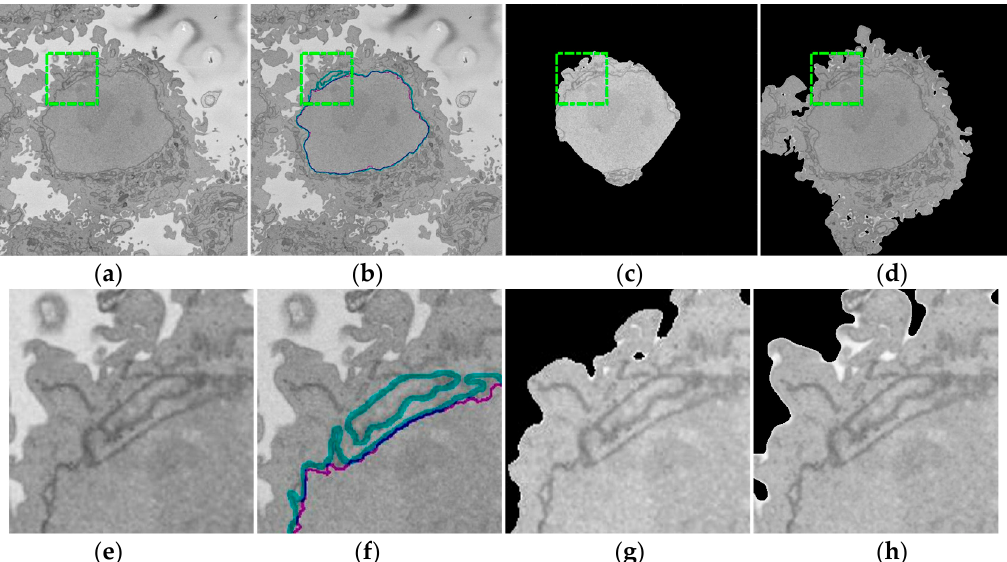
Figure 6. Comparison of the algorithm against ground truth (GT) and Active Contours. ( a ) One representative slice from one HeLa cell (red box in Figure 1b). Green dashed-dotted box denotes the region of interest (ROI) that is magnified in ( e–h ). ( b ) Automated segmentation of the nuclear envelope (NE) (purple). For comparison, the hand segmented GT is shown (cyan). ( c ) Active contours segmentation with 2200 iterations provided the highest Jaccard index (JI) 75%. ( d ) Active contours segmentation with 5000 iterations included large sections of the cell showing the influence of the iterations on the